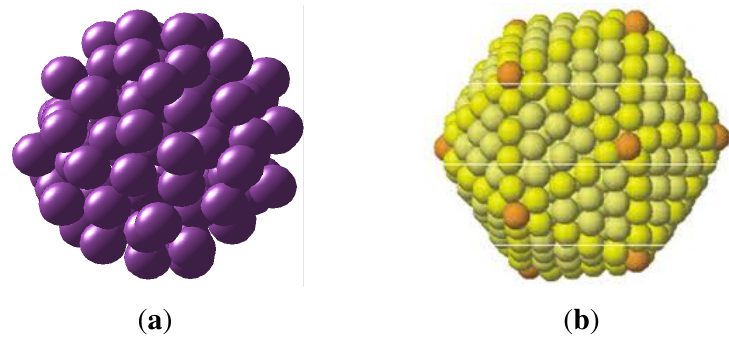
Figure 6. Models of monoatomic random clusters. Left, random cluster with 115 atoms with packing density of approximately 0.62. Right, an ordered cluster with icosahedral structure of 252 atoms and packing density of approximately